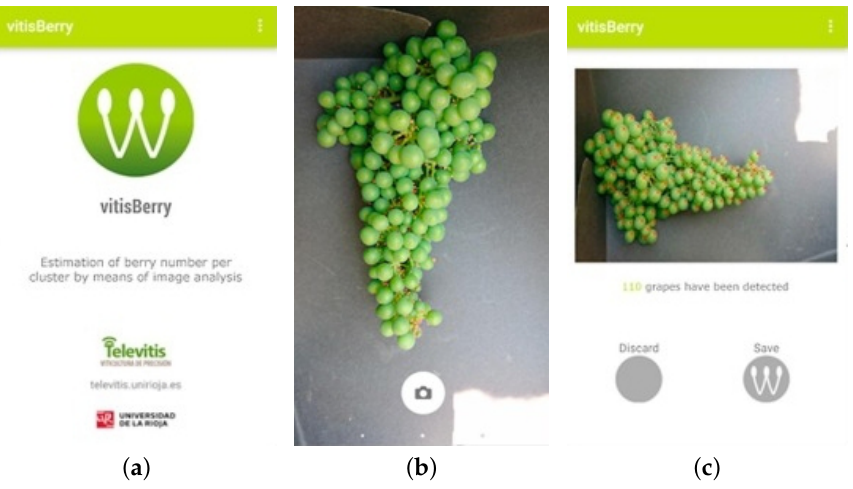
Figure 29. vitisBerry: ( a ) Main menu; ( b ) Capture image interface; ( c ) Grapevine berries detection